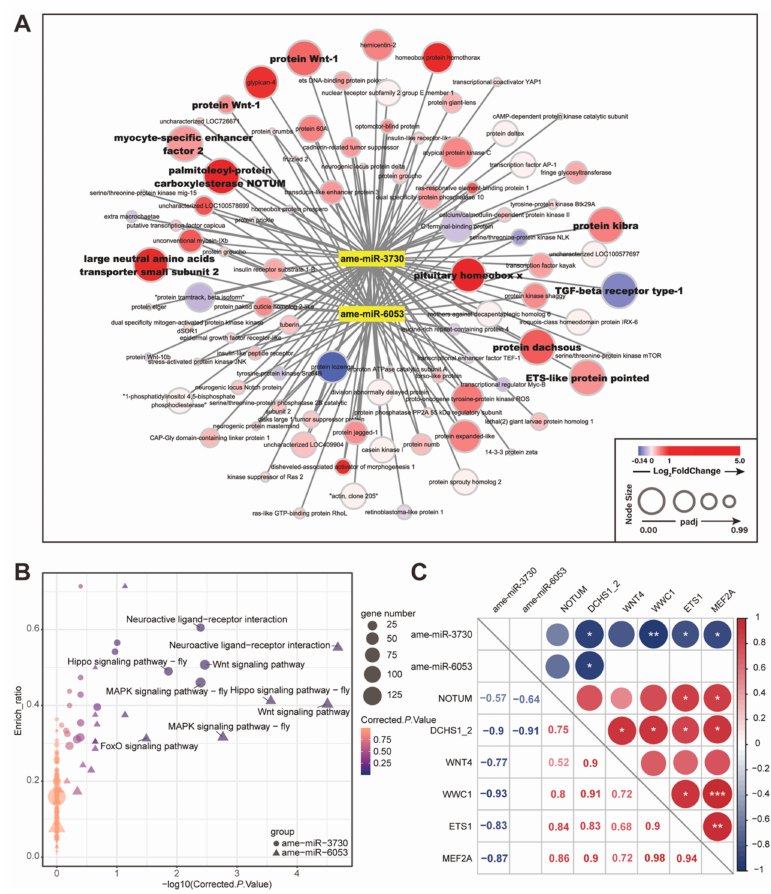
Figure 6. Differentially expressed (DE) miRNAs target developmental genes. ( A ) The network of ame-miR-3730, ame-miR-6053, and 91 predicted target genes in developmental pathways. The node size and color indicate the adjusted p value and log 2 fold-change level of target genes in RNA-seq analysis. Target genes belonging to DE gene sets in RNA-Seq are labeled with bold font. ( B ) Target genes of DE miRNAs were enriched in Wnt, Hippo, and MAPK signaling pathways. The area and color of each point are proportional to the gene number and enriched significance (corrected p -value). ame-miR-3730: circle; ame-miR-6053: triangle. ( C ) Pearson’s correlation coefficients of miRNA-target gene pairs show the significantly negative relationship between DE miRNAs and developmental target genes. The color of red or blue indicates the positive or negative correlation. * p < 0.05, ** p < 0.01, *** p <